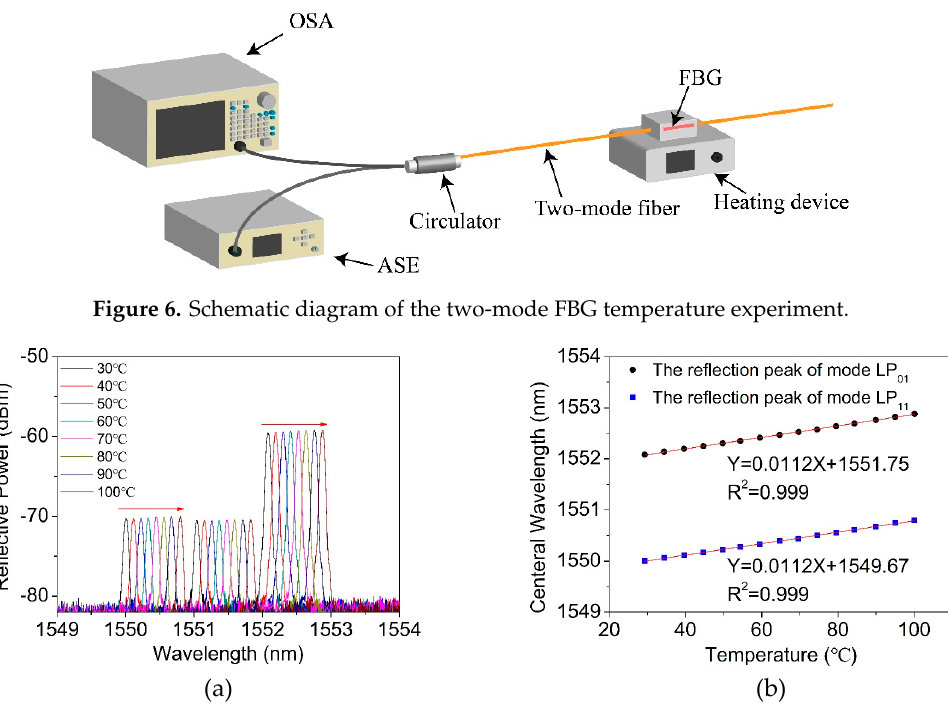
Figure 7. The experimental ( a ) reflection spectra and ( b ) wavelength shift of two-mode FBG with the temperature change.